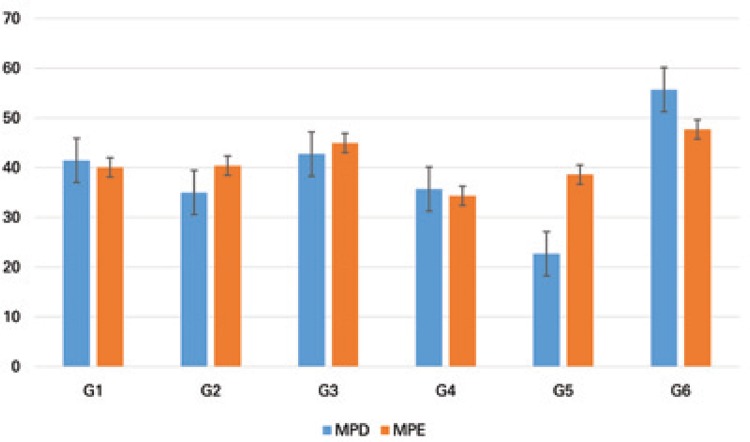
Números de condrócitos na cartilagem articular superior da tíbia (unidade), comparando-se as ratas distribuídas entre os grupos de estudo (G1, G2, G3, G4, G5 e G6) e os membros posteriores direito (alvo) e esquerdo (controle). Letras iguais significam semelhanças e letras diferentes significam diferenças significativas entre os grupos experimentais, para o mesmo lado